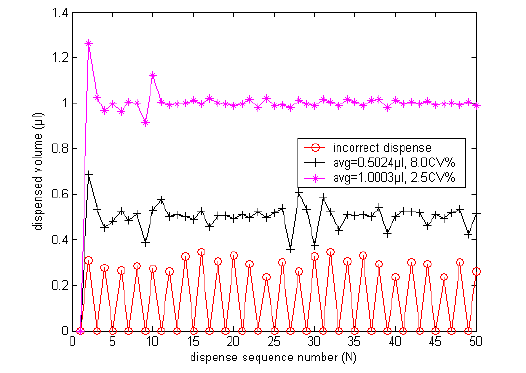
Figure 11. The dispensed volume in each cycle with only RV Compensation